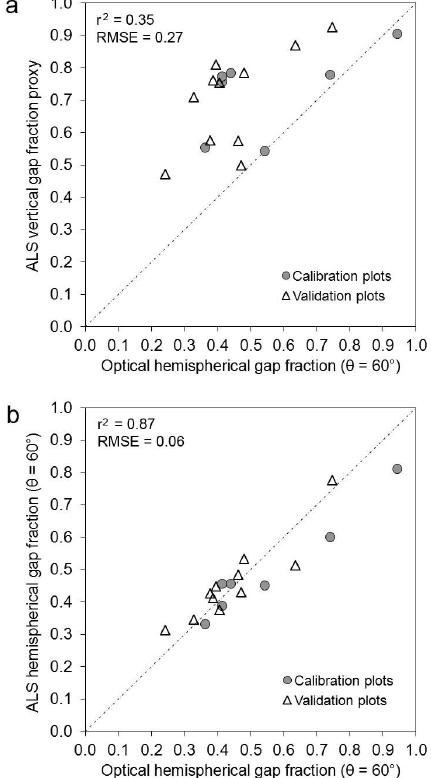
Fig. 7. Comparison between the relationship of plot-level average gap fractions obtained from optical HP and (a) vertical gap frac- tion estimated from untransformed ALS, and (b) gap fractions from calibrated synthetic hemispherical